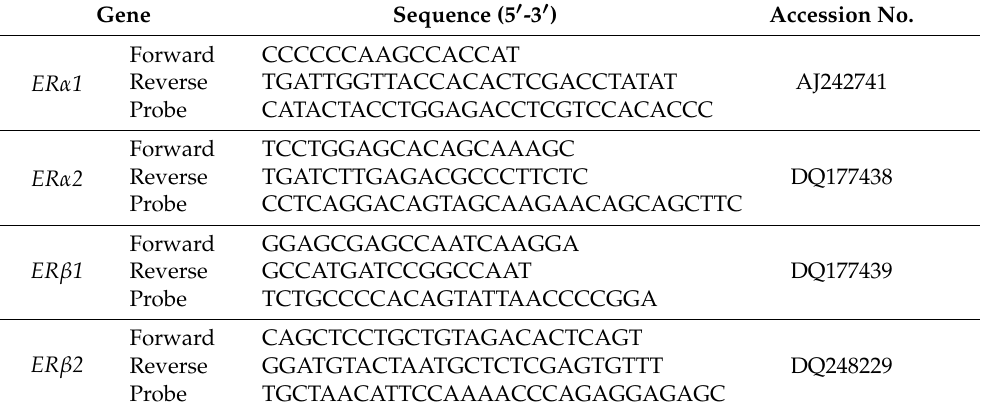
Table 3. Primer sequences used for the gene expression analysis and related accession numbers. Gene Sequence (5 (cid:48) -3 (cid:48) ) Accession